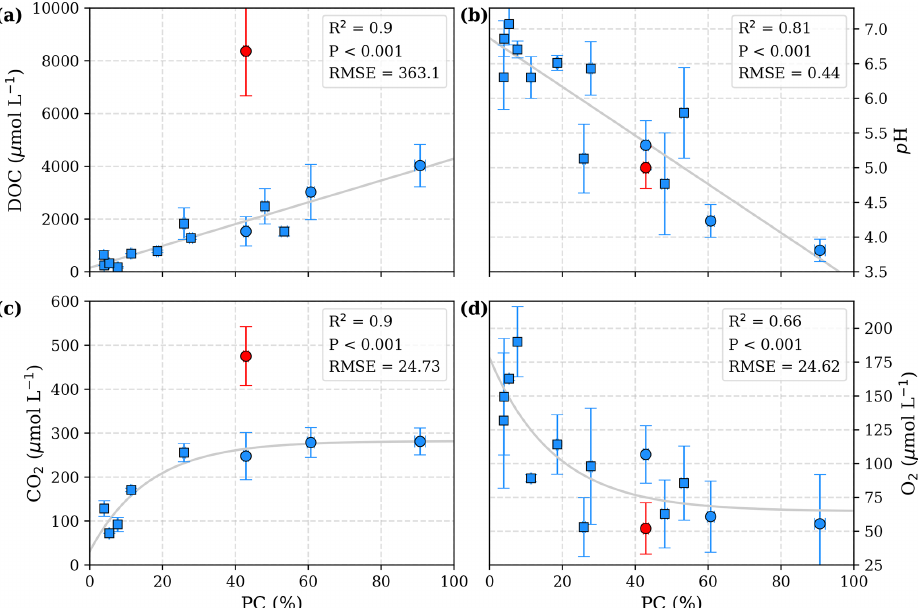
Figure 2. Correlation of peat coverage (PC) with (a) DOC, (b) pH, (c) CO 2 , and (d) O 2 . Each data point represents one river. Variability is indicated by the error bars, which are given by standard deviation. For the Simunjan River, the January 2016 and March 2017 campaigns (Simunjan 2 ; see Tables 3 and 4), indicated by red data points, were separated from the other Simunjan campaigns (Simunjan 1 ) and excluded from the correlations due to strong deviations from the other campaigns that imply an additional process discussed in Sect. 4.4. Ordinary least-squares optimizations were used to calculate linear correlations with DOC and pH and exponential correlations with CO 2 and O 2 . Rivers included in a previous study investigating these correlations (Wit et al., 2015) are indicated by